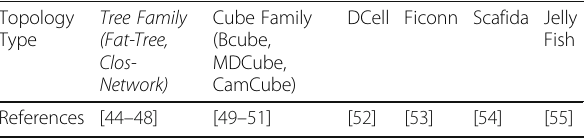
Table 11 List of Assumptions and alternative possibilities: Common